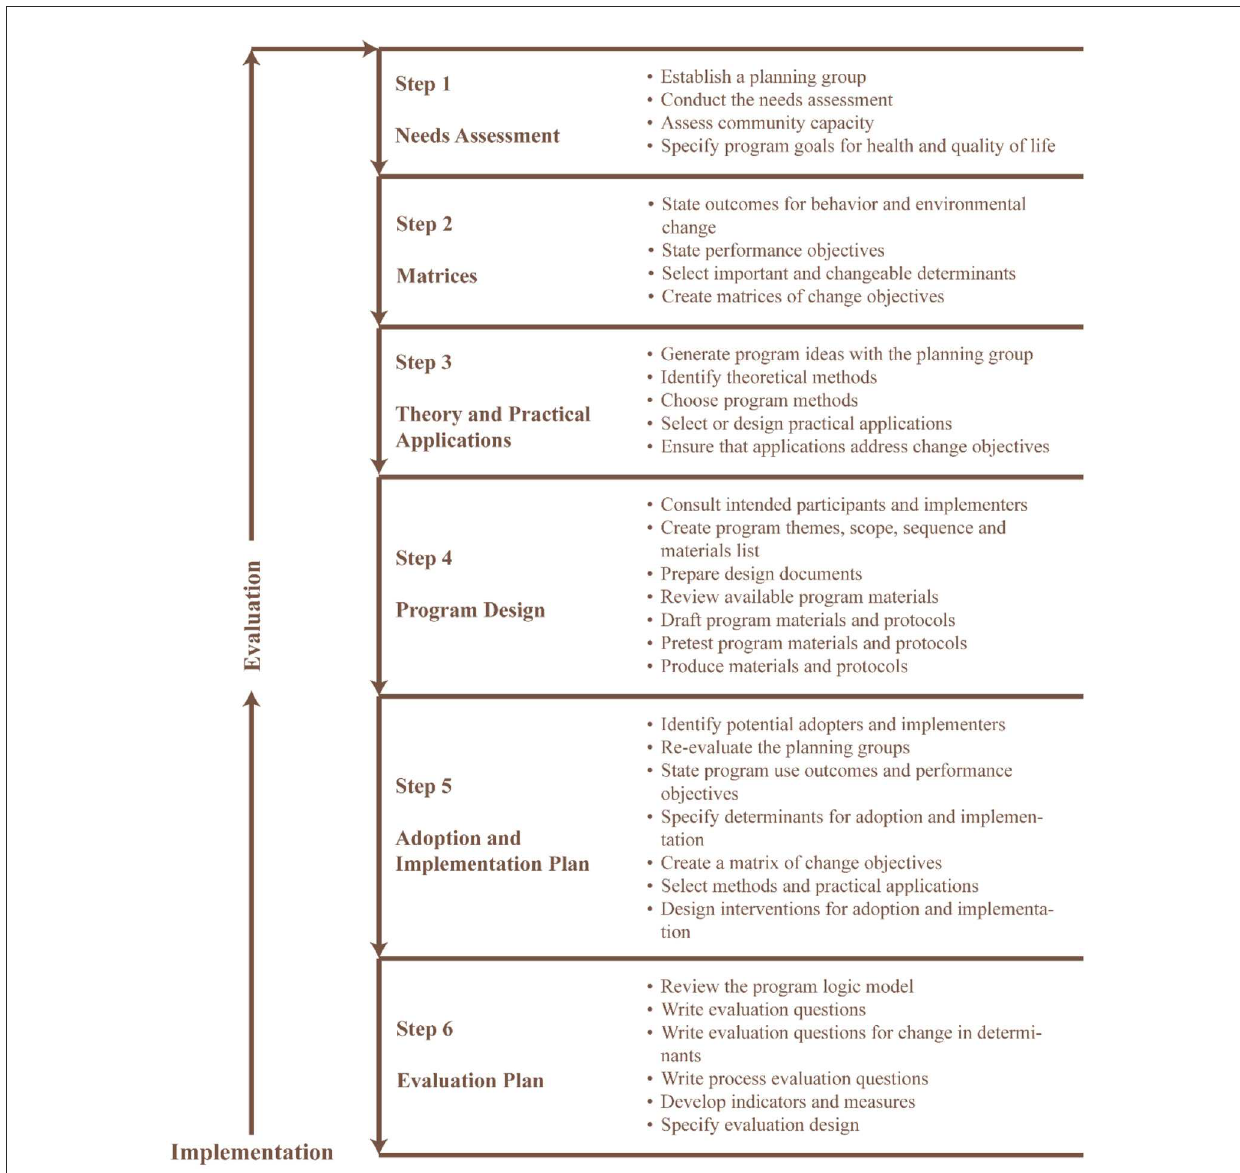
FIGURE1 Six steps intervention mapping approach [adapted from Bartholomew-Eldredge et al. (18), chapter